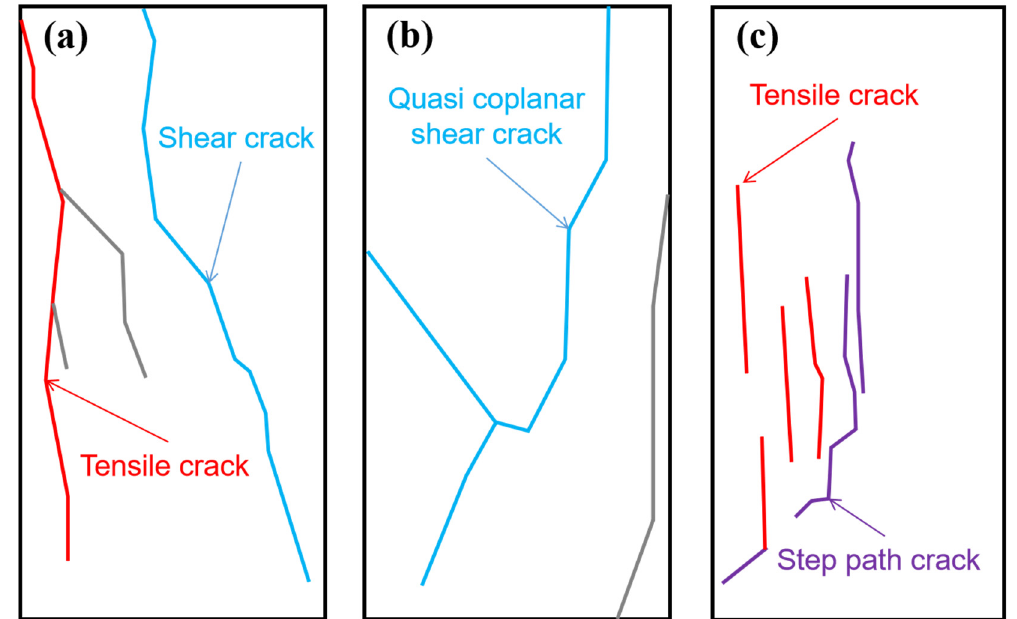
Figure 12. Failure modes of typical specimens. ( a ) Failure mode I; ( b ) failure mode II; ( c ) failure mode III.